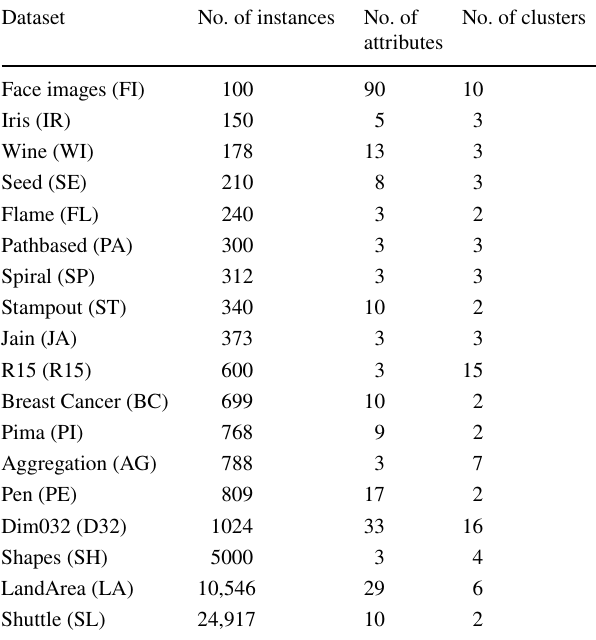
Table 4 The characteristics of the real datasets